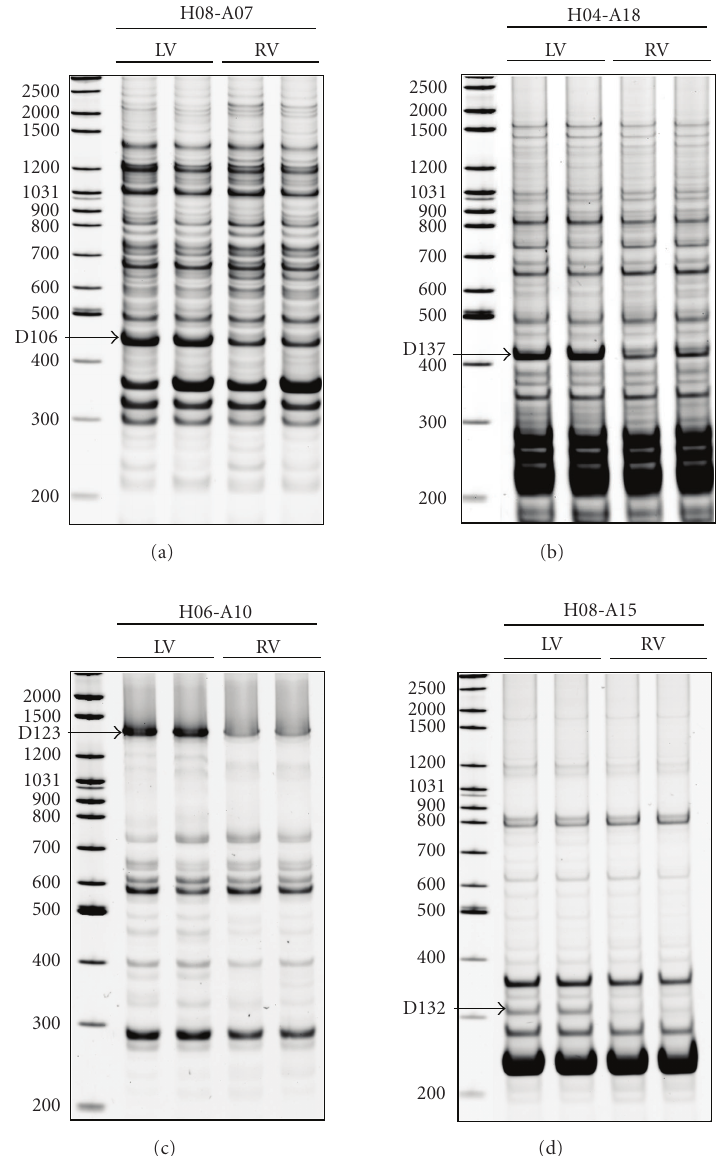
Figure 3: Examples of the bands, displaying over twofold LV versus RV expression di ff erences in newborn piglets. The primer pairs used for DDRT-PCR amplifications are shown. Nondenaturing 8% PAAG poststained with SYBR Green I. LV/RV: left/right ventricle. 200–2500 bp: DNA size standards (GeneRuler DNA ladder mix, Fermentas). Arrows: the bands (D106, D137, D123, and D132), which correspond to the transcripts di ff erentially displayed between LV and RV. For further details see Table